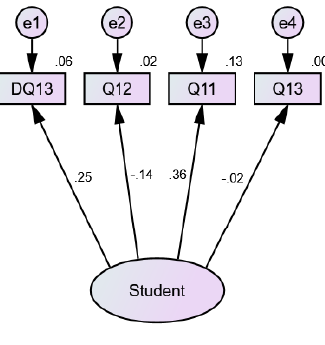
Figure 5. CFA of Figure 5. CFA of STUDENT. Table 7. Standardized direct effects of STUDENT.